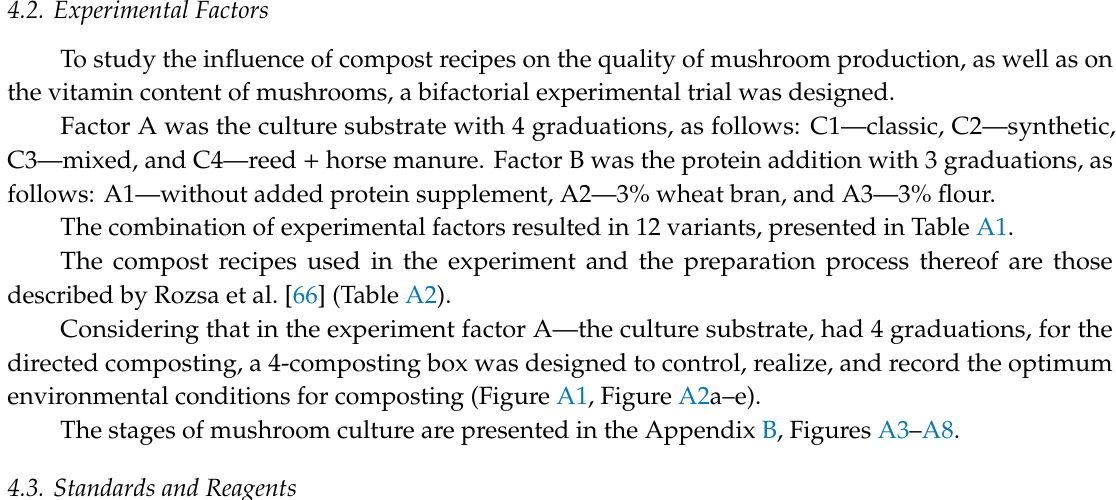
Figure 11. Yellowing the Agaricus blazei Murrill mushroom foot after removing the mycelian base. Source: Photo original—SC CIUPERC Ă RIA SRL, Aghire ș u-Fabrici, Cluj County